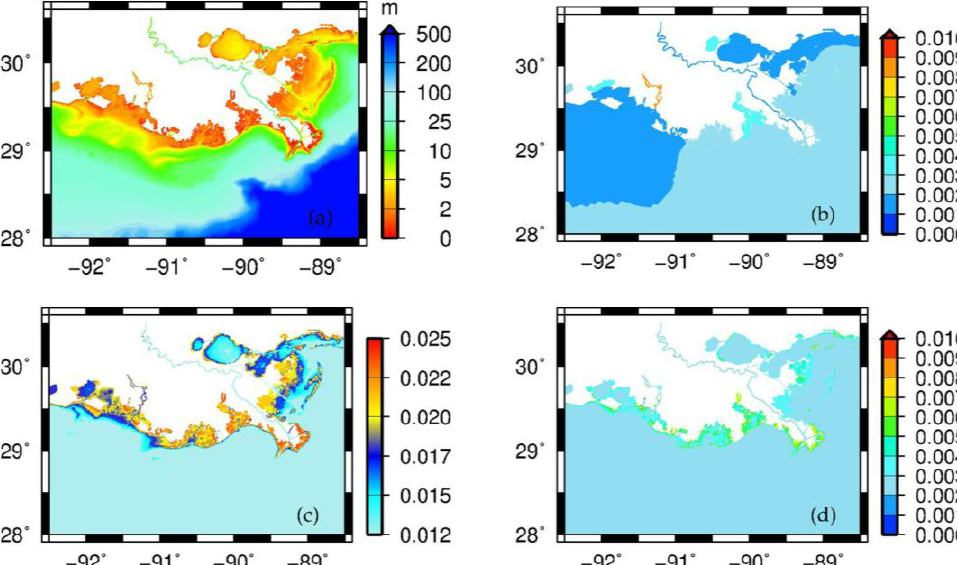
Figure 4. Comparison of bottom friction assignment for the Louisiana coastline: ( a ) bathymetry—scale from 0 m to 500 m, ( b ) assigned VDatum CF values, ( c ) assigned Manning’s n values and ( d ) computed equivalent CF values from bathymetry and assigned Manning’s n values.